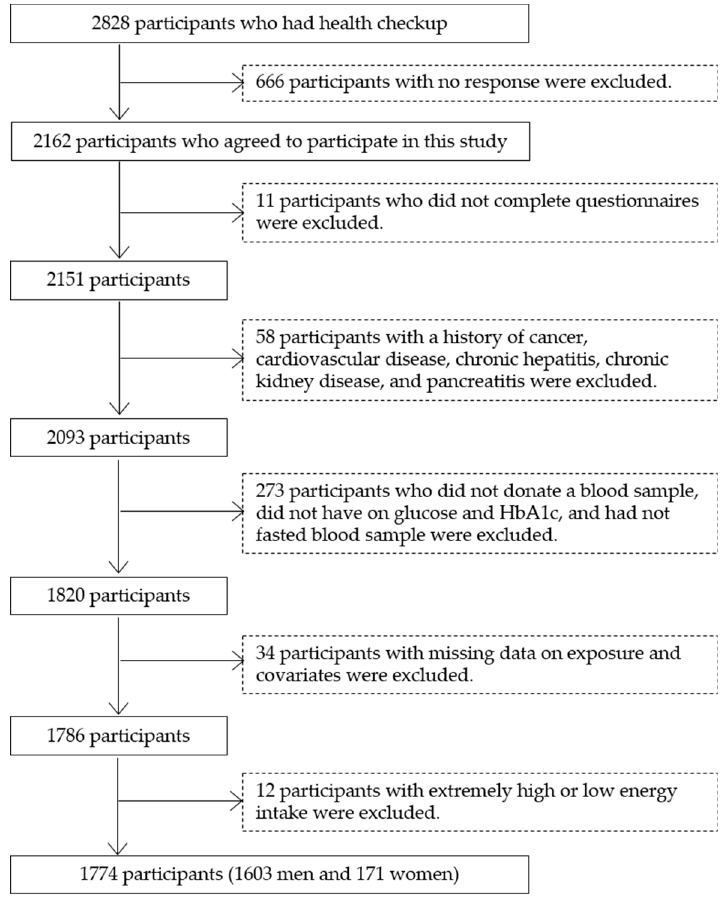
Figure 1. Flowchart of the participants.